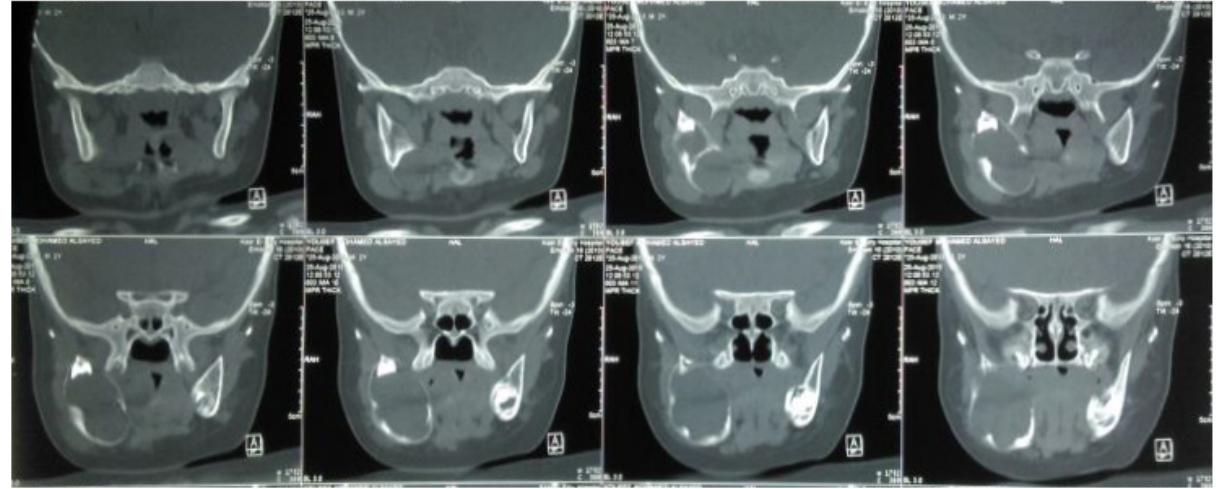
Figure 1. Pre[operative computerized tomography scan revealed an osteolytic multilocular radiolucency at posterior mandible associated with an impacted developing